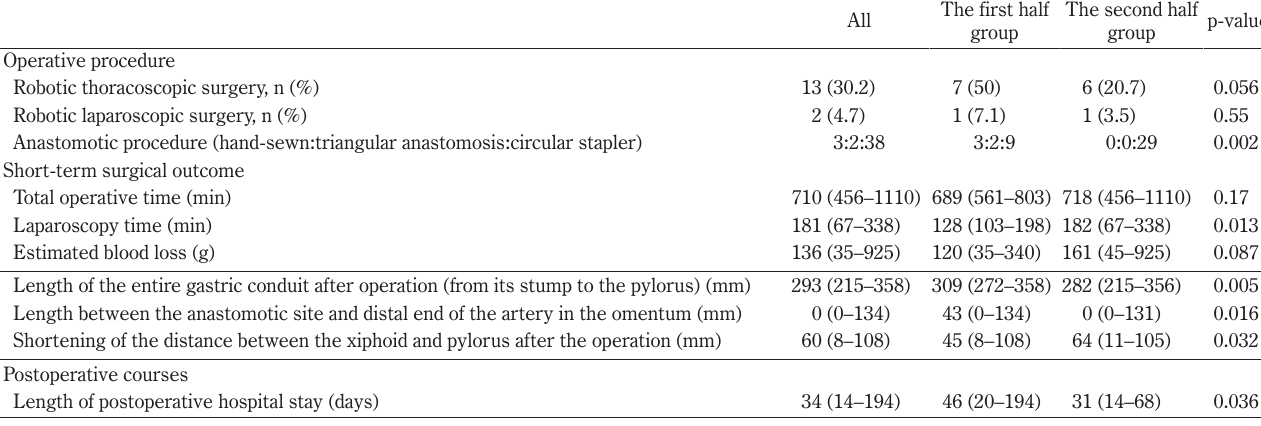
Table 2 Operative procedure, short-term surgical outcomes, and postoperative course